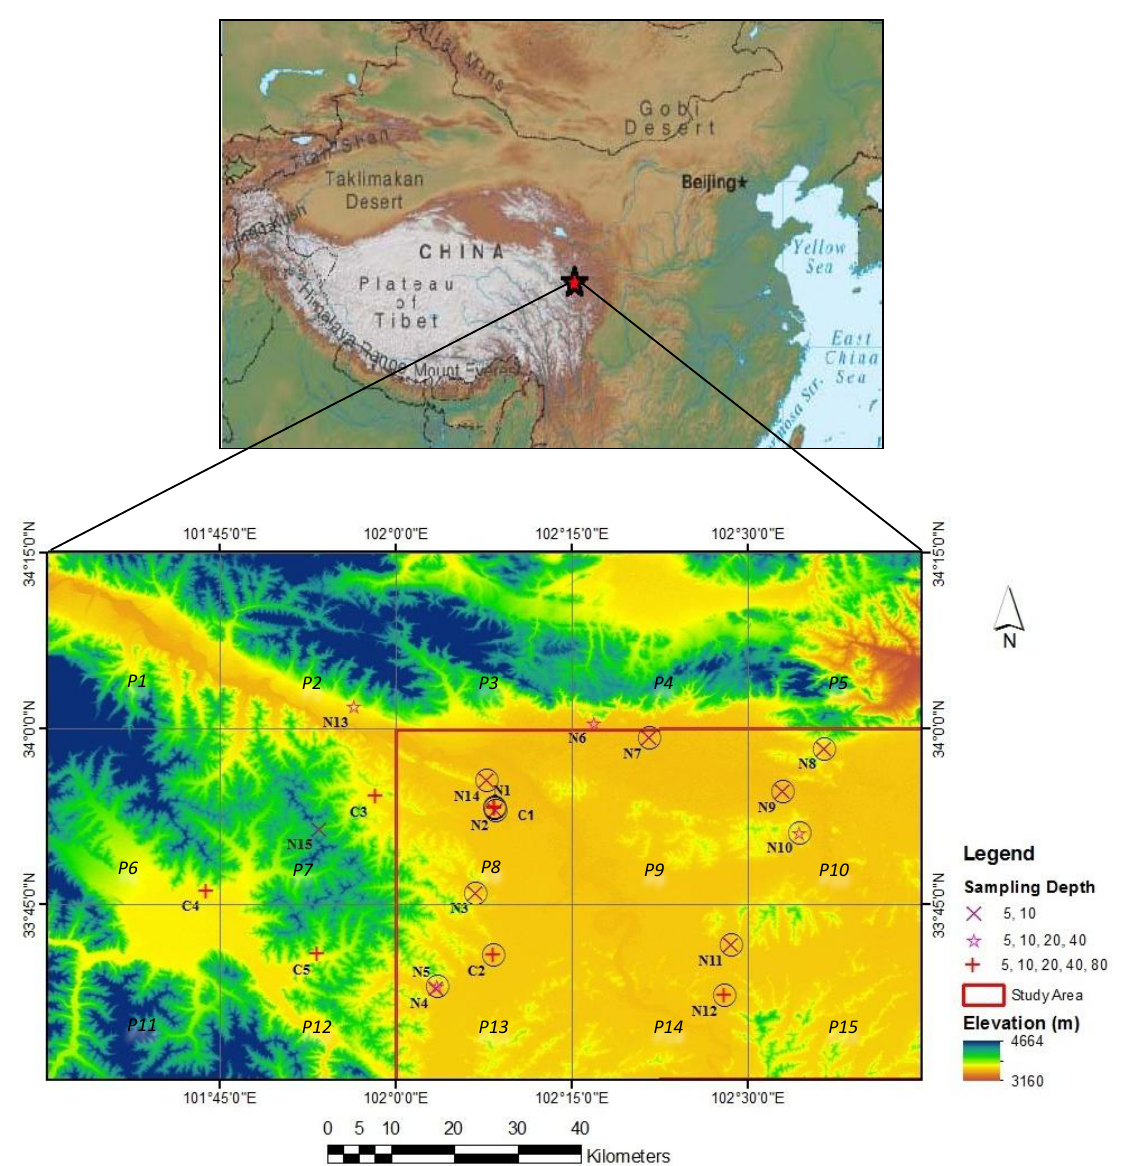
Figure 1. A Shuttle Radar Topography Mission (SRTM) digital elevation model (DEM) of Maqu Area. Station locations are indicated by various symbols. P1, P2,…..P15 represents pixel numbers. Stations selected for analysis are indicated by circles. The red box